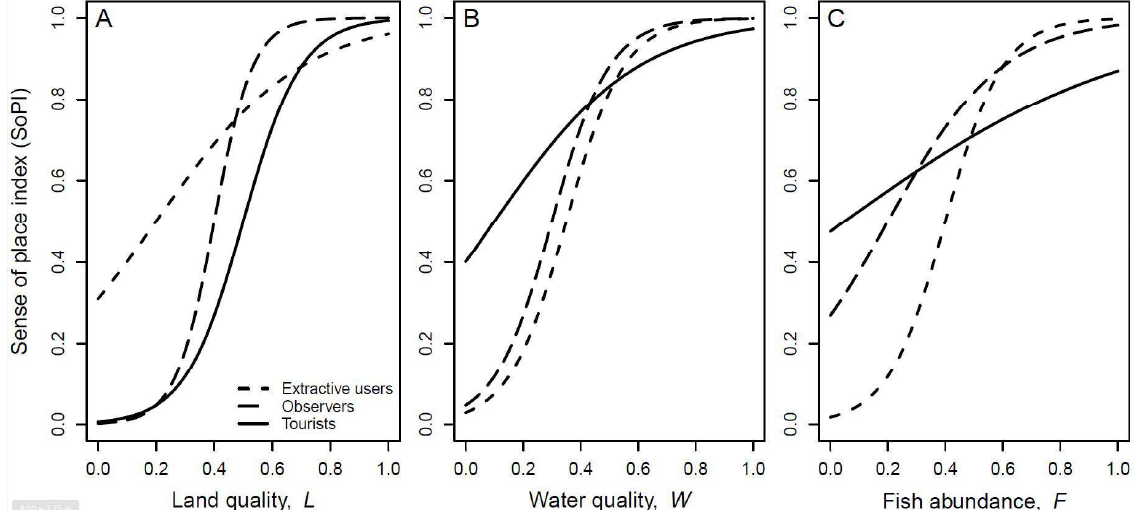
Figure A1.2: Relation between (A) land quality, (B) water quality, and (C) fish abundance and the sense of place index. Curves are plotted for residents who are either extractive users (short-dashed line) or observers (long-dashed line), and tourists (solid line). Unless indicated, the remaining parameters are set to L = W = F = 1 and T =